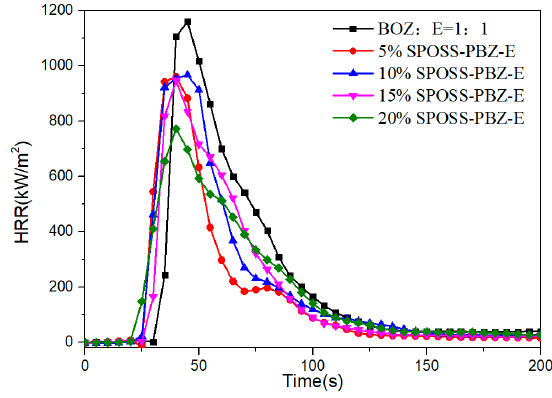
Figure 12. Heat release rate curves of the SPOSS-BOZ nanocomposites.